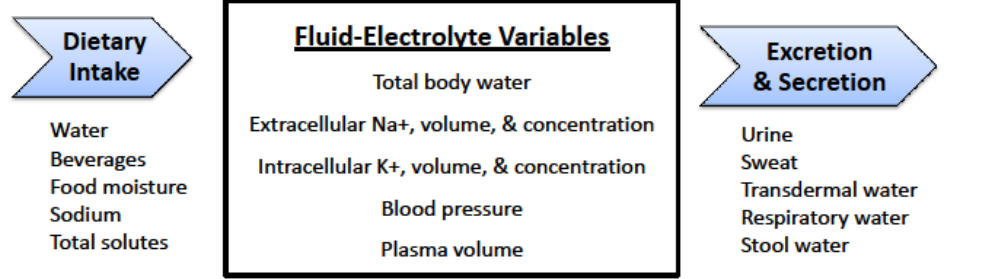
Figure 1. Variables that are regulated as part of body water homeostasis.